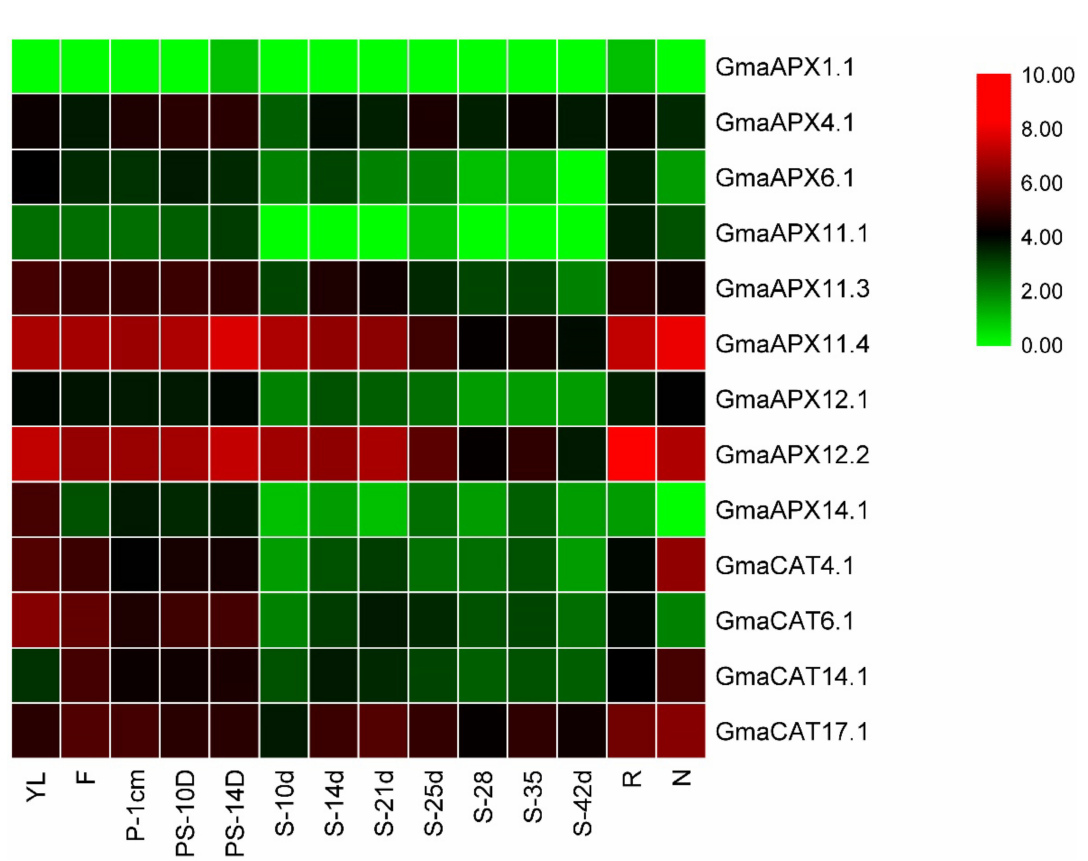
Figure 7. Hierarchical clustering of expression profiles of soybean APX and CAT genes in different tissues. YL (young leaves), F (flower), P.1cm (one cm pod), PS.10d (10 DAF pod shell), PS.14d (14 DAF pod shell), S.10d (10 DAF seed), S.14d (14 DAF seed), S.21d (21 DAF seed), S.25d (25 DAF seed), S.28d (28 DAF seed), S.35d (35 DAF seed), S.42d (42 DAF seed), R (root), N (nodule). These